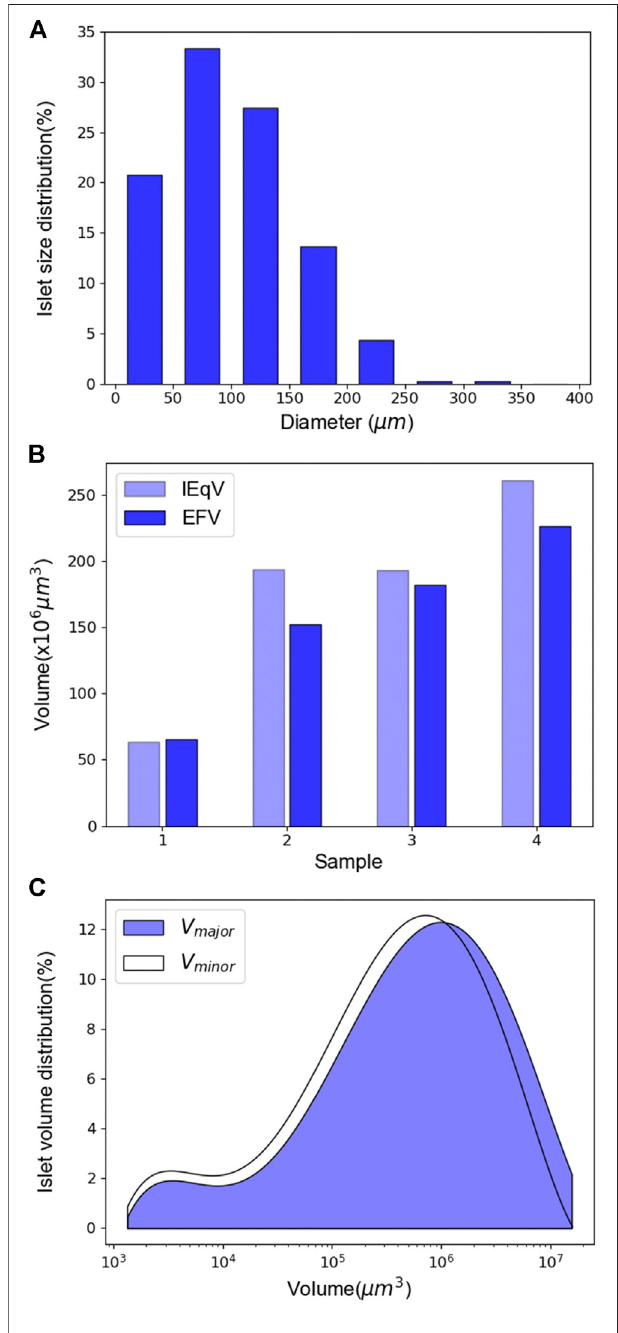
FIGURE 7 | Islet diameter and volume assessment. (A) Distribution of islet diameter. The mean diameter of the islet sample is 99.87 ± 53.91 µm. N (cid:1) 628. (B) Comparison between IEqV and EFV. N (cid:1) 4. (C) Distribution curvesofthe volume calculated using the two different methods. N (cid:1)